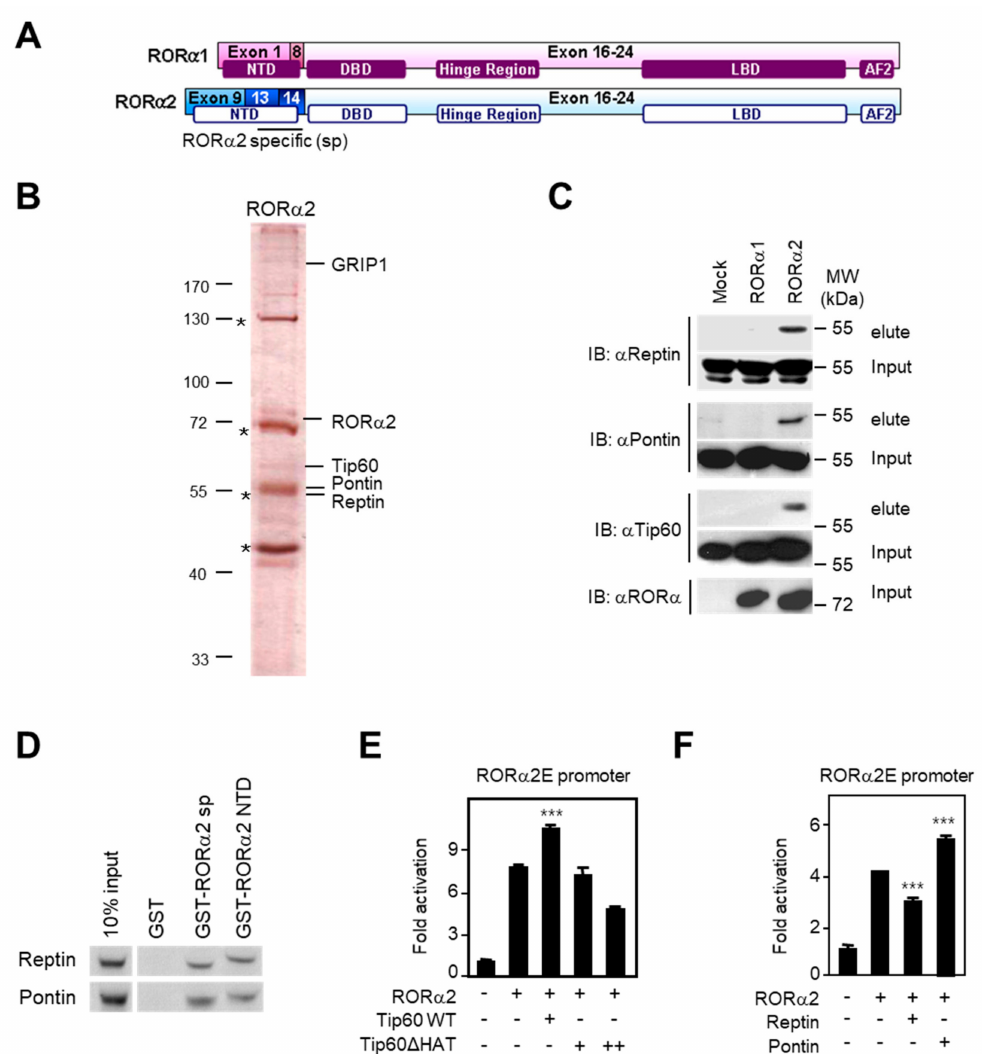
Figure 2. ROR α 2 complexes incorporate pontin / Tip60 and reptin through ROR α 2-specific N-terminal domain (NTD). ( A ) Schematic presentation of the ROR α 1 and ROR α 2 isoforms. NTDs of ROR α 1 and ROR α 2 are significantly di ff erent. ( B ) ROR α 2-binding proteins were purified from extracts obtained from HEK293 cells stably expressing Flag-tagged ROR α 2. The bound proteins were resolved by SDS-PAGE and prepared for LC-MS / MS analysis. ( C ) Western blot analysis indicates that ROR α 2 specifically binds to reptin, pontin, and Tip60. ( D ) Glutathione S-transferase (GST) pulldown assay shows the direct interaction of GST–ROR α 2 sp (Exon 13 and 14) or GST-ROR α 2 NTD (Exon 9, 13, and 14) with reptin and pontin. ( E and F ) Luciferase reporter assays were conducted after co-transfection with ROR α 2E luciferase reporter. Expression of Tip60 activated ROR α 2E-luciferase reporter, but reporter was not activated by Tip60 ∆ HAT, an acetyltransferase enzymatic deletion mutant ( E ). Co-transfection of ROR α 2 and Tip60 WT significantly increased reporter activities than ROR α 2 only transfected control (*** p < 0.001). Expression of reptin repressed ROR α 2E luciferase reporter, whereas elevated